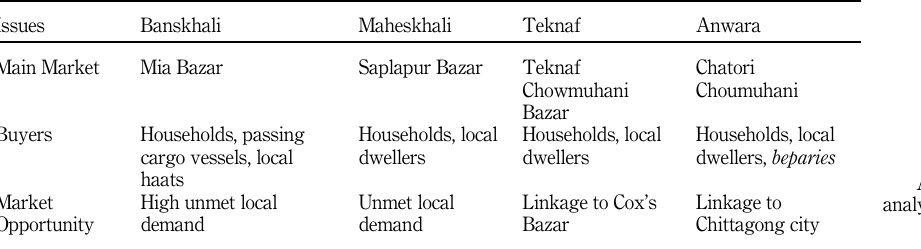
Table 8. Area-wise market analysis for vegetable